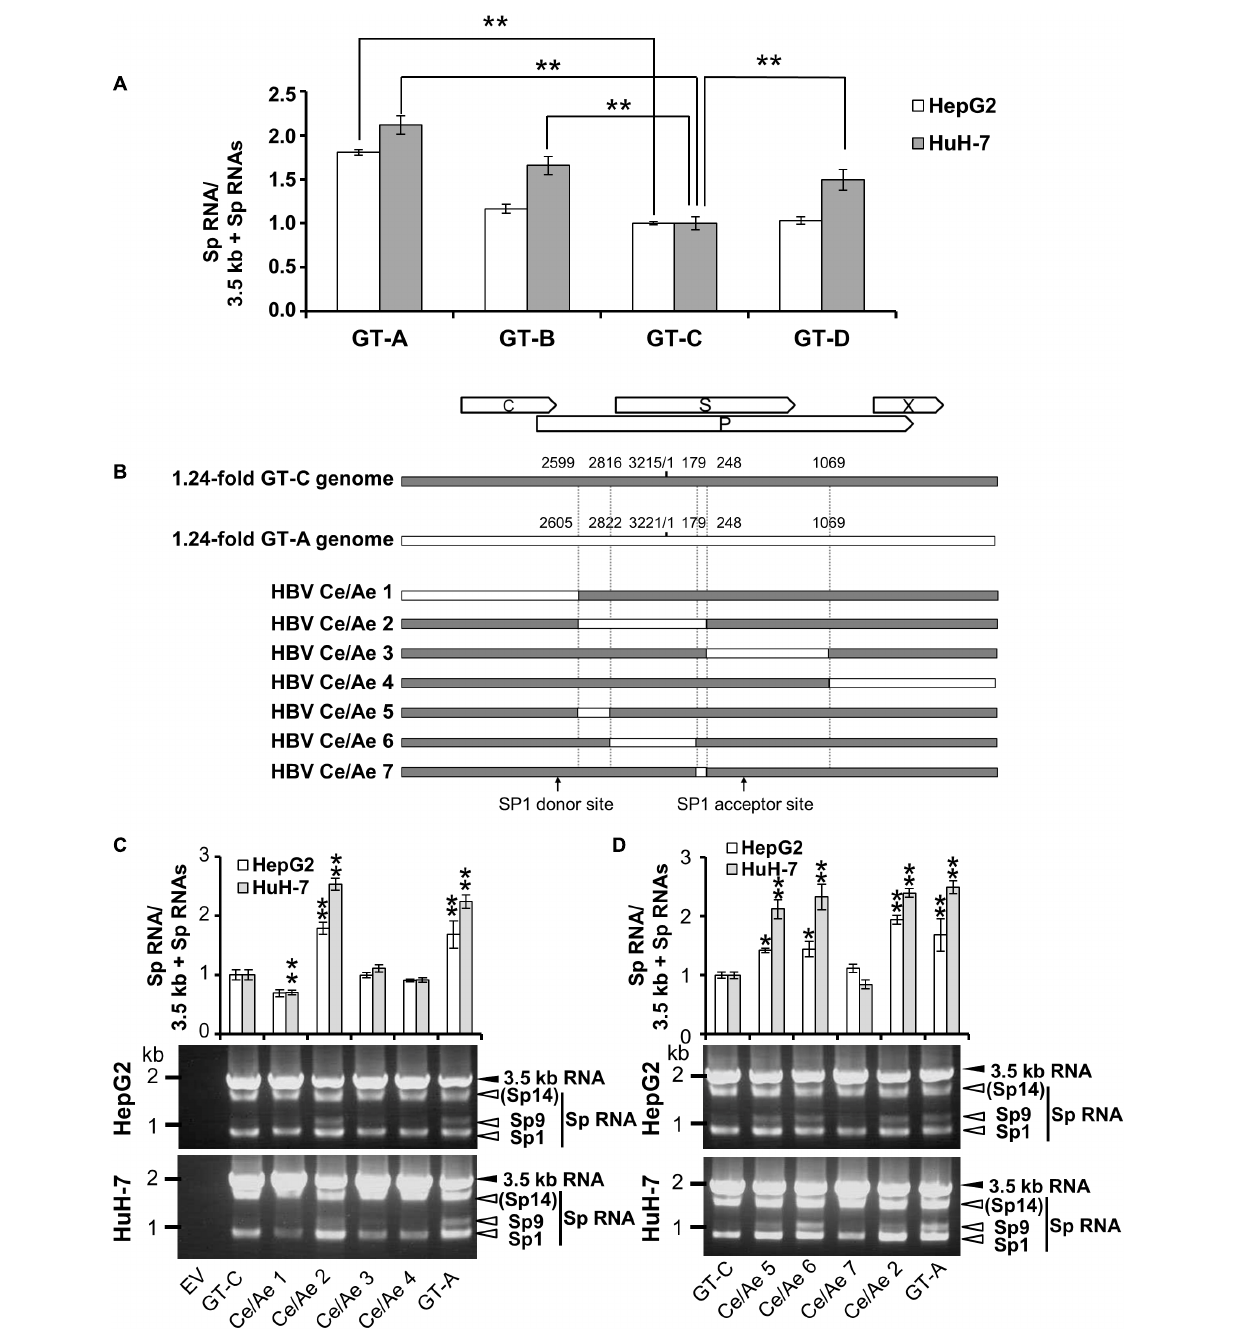
FIGURE 5 | Diversity in the splicing efficiency among HBV genotypes/strains. (A) pUC-HB-Ae (GT-A), -Bj56 (GT-B), -Ce (GT-C) or -D_Ind60 (GT-D) was transfected into HepG2 and HuH-7 cells. Two days after the transfection, total RNA was extracted from cells and analyzed by qRT-PCR to determine the levels of 3.5 kb RNA and spliced RNAs. The quantity ratios of the spliced RNAs to total 3.5 kb RNA derived RNA species were calculated and that of GT-C was set to 1. (B) A schematic representation of a series of mutated HBV genomes replacing parts of the GT-C sequence with corresponding parts of GT-A sequence. Positions of donor and acceptor sites of SP1 RNA are indicated. (C) qRT-PCR analysis was performed to determine 3.5 kb RNA and spliced RNA levels in HepG2 and HuH-7 cells transfected with pUC-HB- Ce (GT-C), -Ae (GT-A), HBV Ce/Ae1, /Ae2, /Ae3 or /Ae4. The quantity ratios of the spliced RNAs to total 3.5 kb RNA derived RNA species were calculated and those in GT-C-expressing cells were set to 1 (upper). Representative pattern for RT-PCR result indicating expression of unspliced and spliced (Sp) RNAs derived from 3.5 kb RNA in the transfected HepG2 (middle) and HuH-7 cells (lower). (D) As in (C) but mutated genomes HBV Ce/Ae5, /Ae6, /Ae7 as well as GT-C, -A and HBV Ce/Ae2 were used for expression of HBV RNAs. Values represent mean ± SD (HepG2; n = 2, HuH-7; n = 3). ∗ p < 0.05, ∗∗ p < 0.01, by one-way ANOVA followed by Dunnett’s test compared to GT-C.